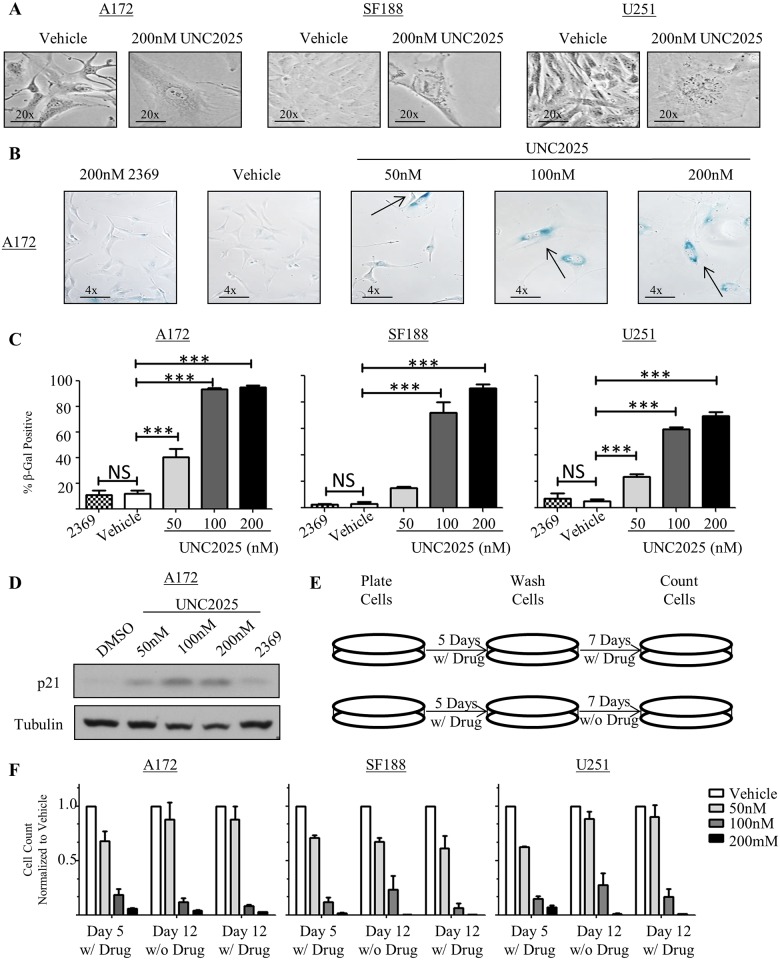
UNC2025 induces cellular senescence in GBM cells.A172, SF188, and U251 cells were treated with the indicated concentrations of UNC2025, UNC2369 control TKI (200nM), or vehicle (DMSO). (A) GBM cells treated with UNC2025 exhibit an altered morphology compared to vehicle (DMSO) treated cells. Representative images from three independent experiments are shown. (B-C) Cells were treated for five days, then fixed and stained to determine beta-galactosidase activity (blue staining = positive). Representative images of the A172 cell line (B) and mean values and standard errors derived from four independent experiments for all three cell lines (C) are shown. (D) A172 cells were treated for 72 hours and p21 protein, a senescence marker, was detected in cell lysates by immunoblot. Representative images from three independent experiments are shown. (E) Schematic of experiment performed in (F). (F) Cells were treated for five days, then media were replaced with fresh medium with or without UNC2025 and cells were cultured for an additional seven days. Viable cells were counted by trypan blue exclusion on days five and twelve. Mean values and standard errors were derived from four independent experiments, statistical analysis revealed no difference between continual drug and drug recovery. (*p<0.5, **p<0.01, ***p<0.001, 1-sided ANOVA).